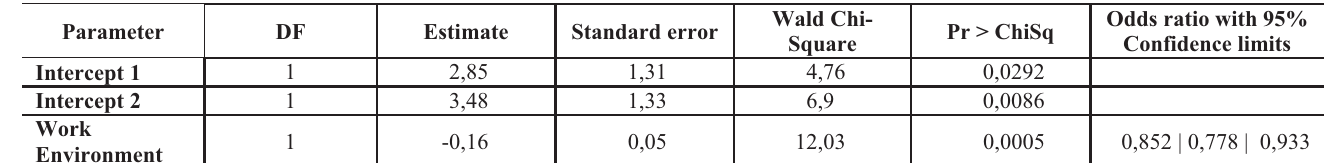
Table 6: Parameter estimates for logistic